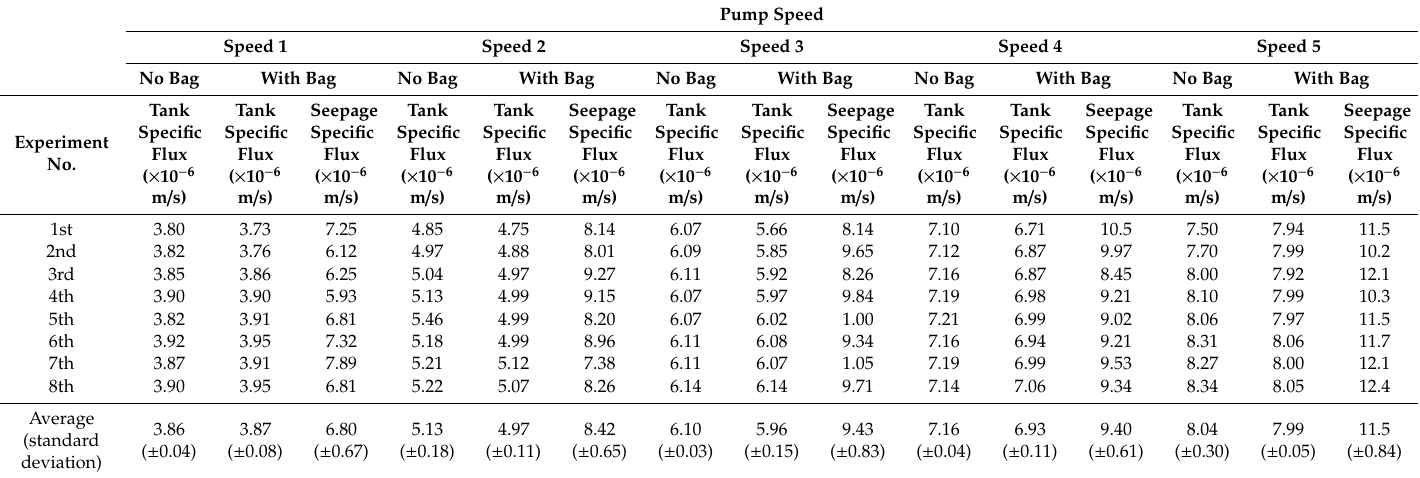
Table 5. Outflux measurement experiment using the Type 2 collection